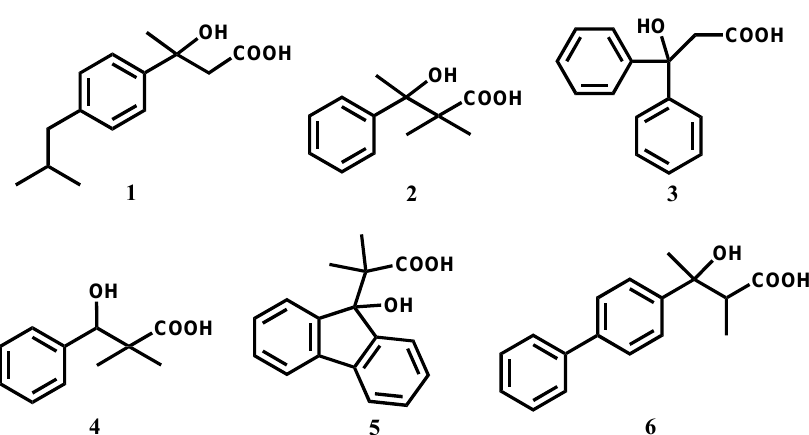
Figure 1 . Structures of the studied compounds.